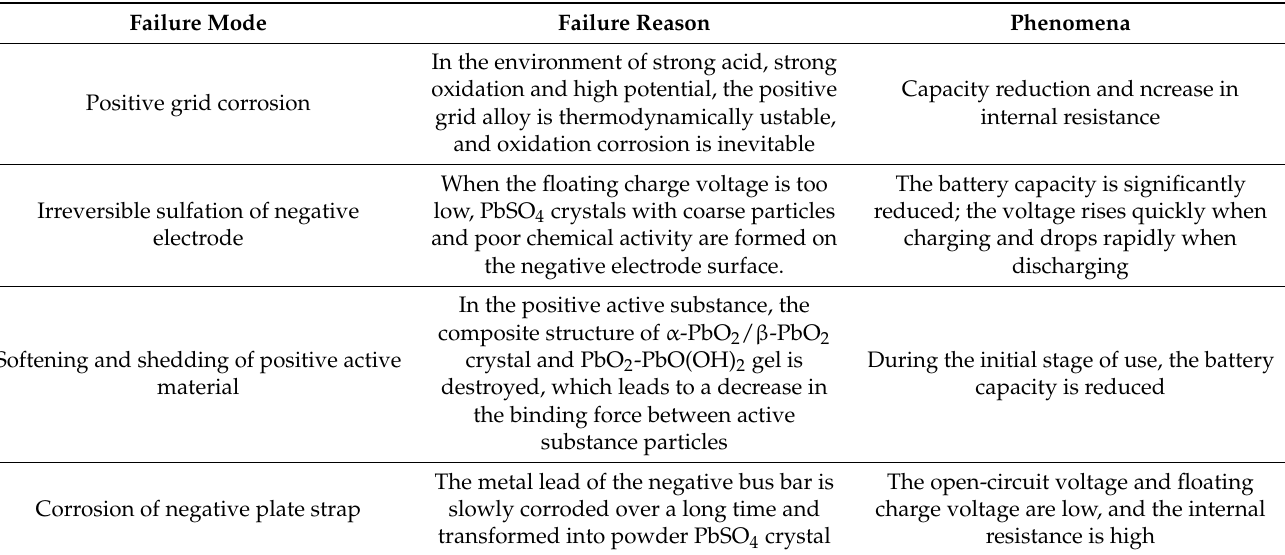
Table 1. VRLA battery failure